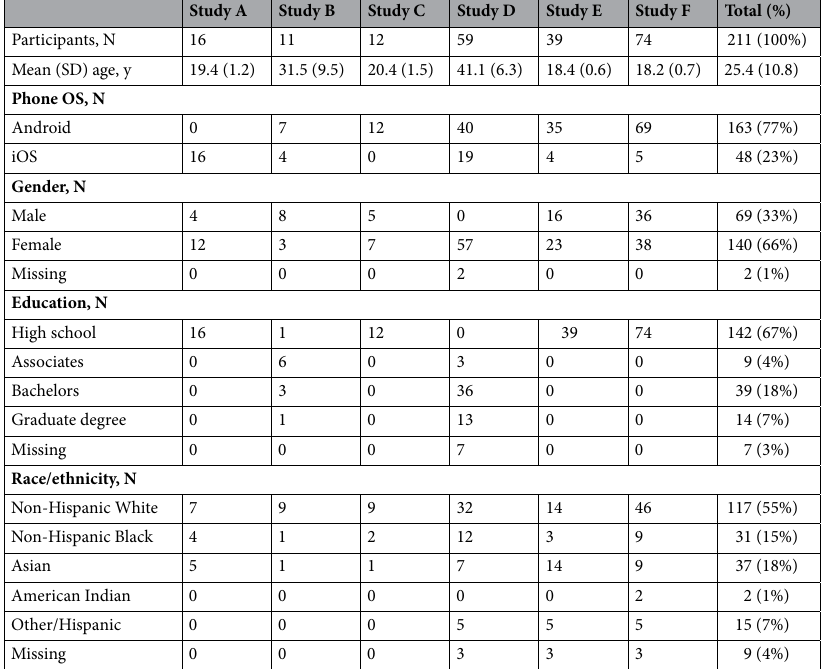
Table 1. Study demographic characteristics. General sociodemographic characteristics of each study and across all studies. Studies A, C, E, and F consisted of healthy undergraduate students from Harvard the Total column shows the row percent relative to the entire sample except for the age row where it shows the sample standard deviation of age in